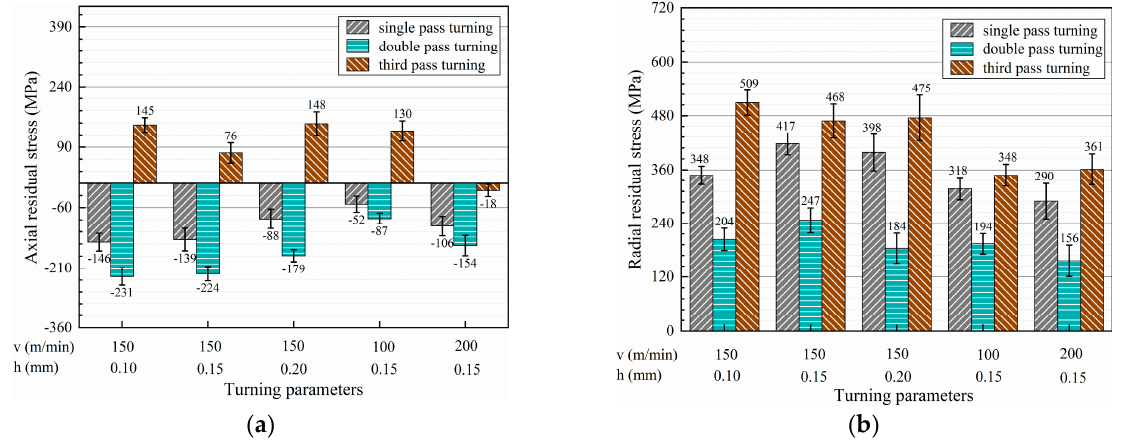
Figure 7. Surface residual stresses under multi-pass turning conditions: ( a ) surface residual stress in the axial direction and ( b ) surface residual stress in the radial direction.